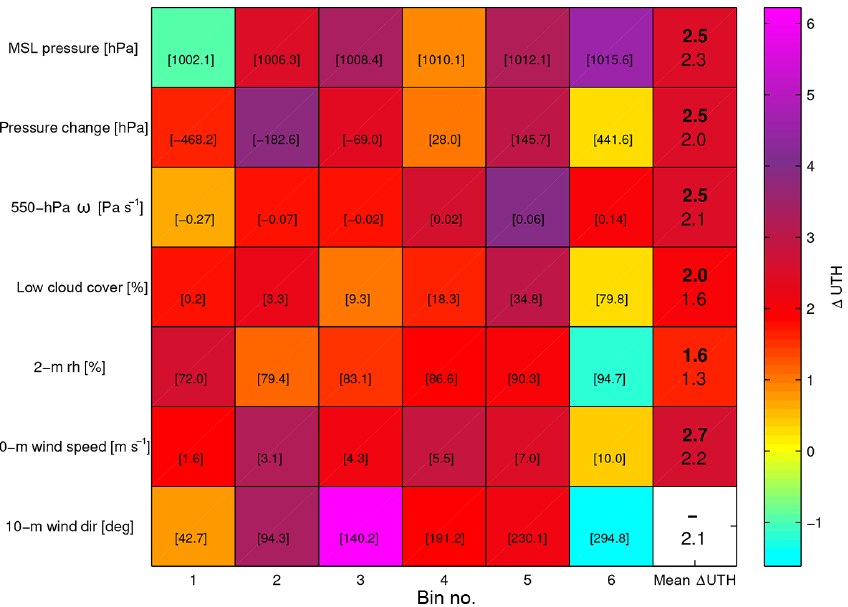
Figure 10. Meteorological covariation. After binning with precipitation, data was binned to 6 bins according to the value of several meteo- rological variables from ERA-Interim reanalysis: mean sea level (m.s.l.) pressure, pressure change from the previous day, 550hPa vertical velocity in pressure coordinates ( ω ), low cloud cover, 2m relative humidity, 10m wind speed and 10m wind direction (wind dir). These variables were chosen as they are expected to change considerably during the passage of synoptic (and mesoscale) disturbances. Change in UTH ( (cid:49) UTH = UTH(AOD ≥ 0.18) − UTH(AOD < 0.18)) is shown separately for the 6 bins and the mean over the 6 bins in the last column. For each meteorological variable, each of the 6 bins contains equal amount of data. The values increase from left to right except for 10m wind direction for which the values go from north-easterly to north-westerly wind directions. Mean values of the meteorological variables in each bin are presented in parenthesis. In the last column, the upper value is the mean of (cid:49) UTH in bins 2–5 and the lower value is the mean of (cid:49) UTH in all 6 bins. If the observed increase in UTH would be caused by some of these meteorological variables, (cid:49) UTH should go to zero when binned according to this variable. As no such behaviour is observed, we conclude that meteorological covariation is not the cause of the obtained results. Also, (cid:49) UTH shows no systematic behaviour according to any of the meteorological variables. Table 3. Radiative effect related to (cid:49) UTH. Outgoing longwave radiation (OLR) and radiative effect (RE) caused by a decrease in OLR when relative humidity in the upper troposphere (500–200hPa) is increased by 1, 2, 5, and 10 percentage units in the tropical moist (TM) and midlatitude dry (MLD) air reference soundings of Dunion (2011). TM MLD OLR (Wm − 2 ) RE (Wm − 2 ) OLR (Wm − 2